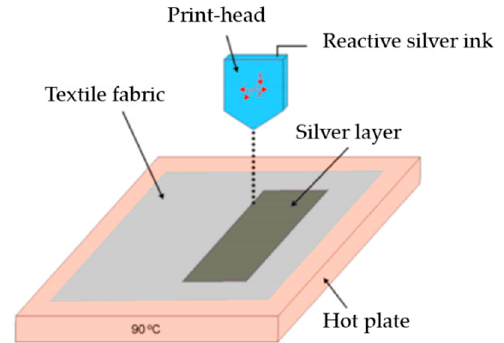
Figure 6. Silver deposition on textile surface using inkjet printing, reproduced with permission from